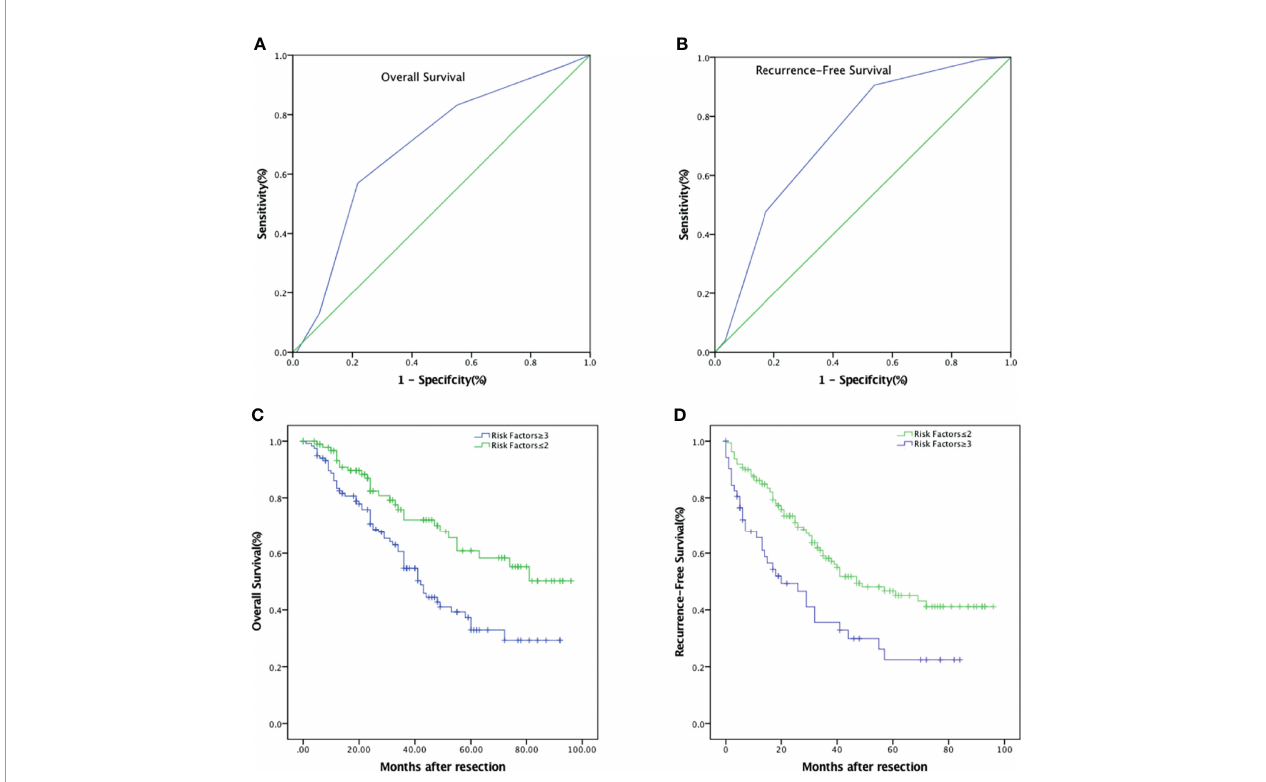
FIGURE 5 | Combinations of independent risk factors better predict survival of patients with HCC after hepatic resection. (A) ROC of combined risk factors for the prediction of OS. (B) ROC of combined risk factors for the prediction of RFS. (C) OS curve comparing risk factors ≥ 3 and risk factors ≤ 2. (D) RFS curve comparing risk factors ≥ 3 and risk factors ≤